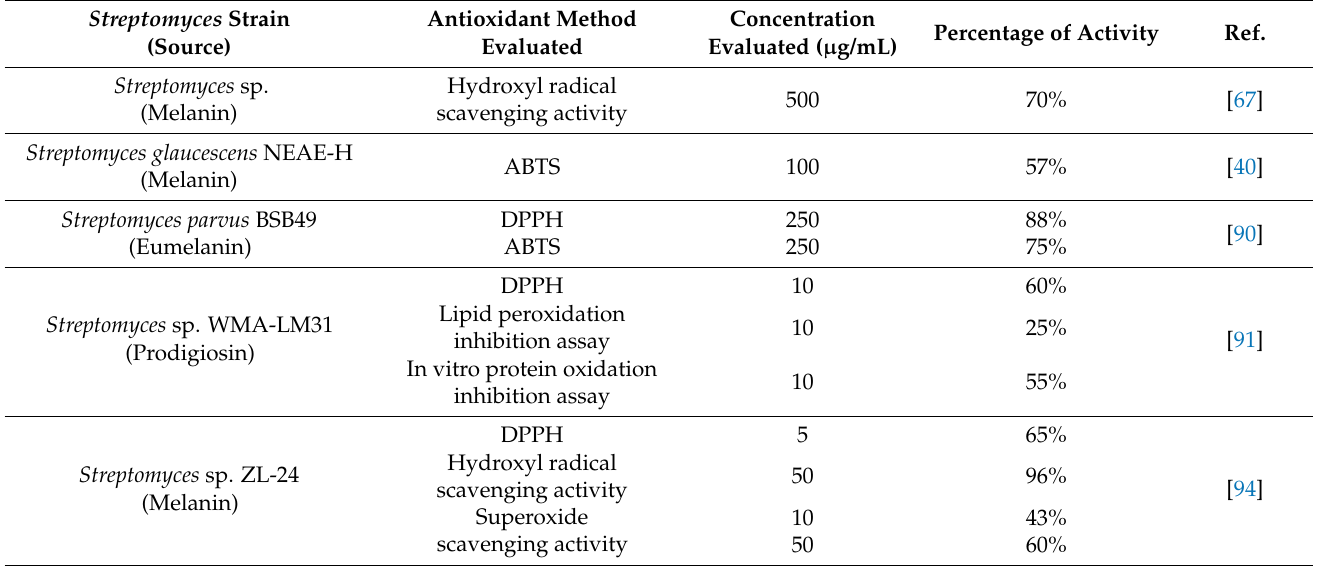
Table 8. Results (concentration evaluated and percentage) of the Streptomyces strains with antioxidant activity